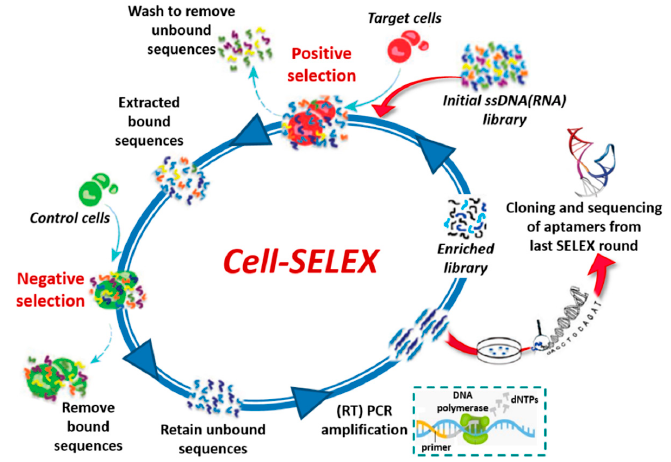
Figure 3. Schematic representation of cell - SELEX process.